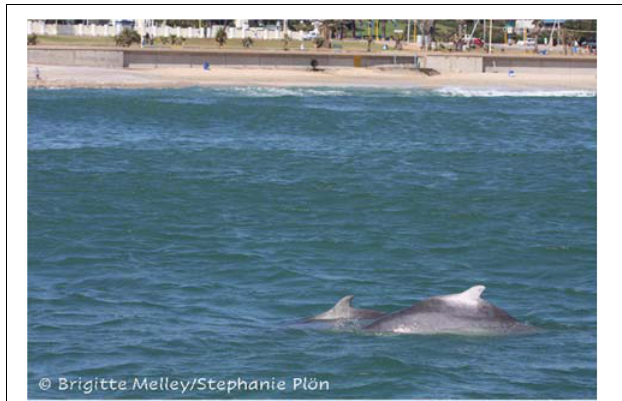
FIGURE 1 | Indian Ocean Humpback dolphins are very coastal, exposing them to a number of anthropogenic threats (Photo credit: S. Plön).